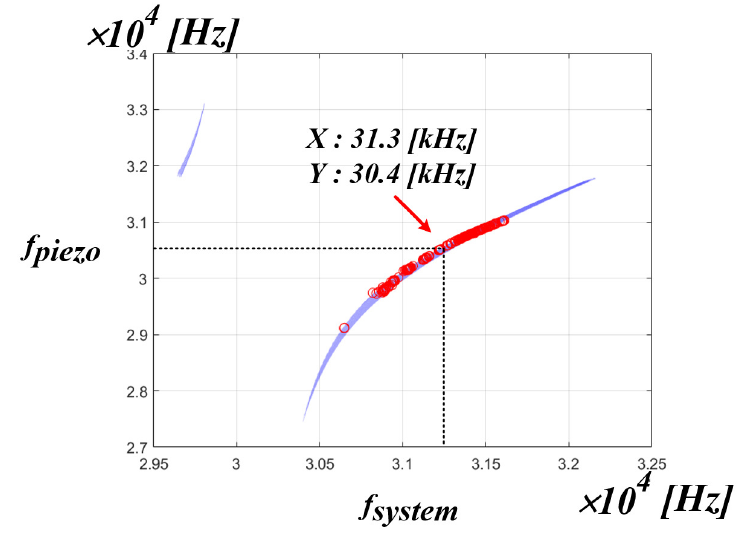
Figure 25. Curve fitting data 1.